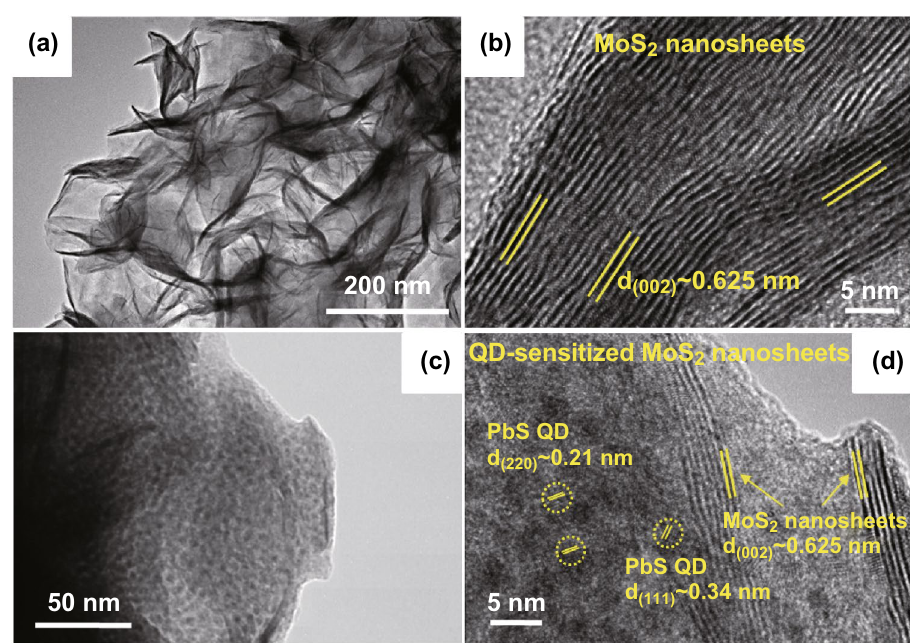
Fig. 2 Morphology of the MoS 2 nanosheets and QD‑sensitized MoS 2 nanosheets: a , b TEM images of the flowerlike MoS 2 nanosheets and c , d QD‑sensitized MoS 2 nanosheets at different magnifications, showing a lattice space of 0.625 nm corresponding to the (002) lattice plane of MoS 2 , and 0.21, 0.34 nm corresponding to the (220), (111) lattice planes of PbS, respectively